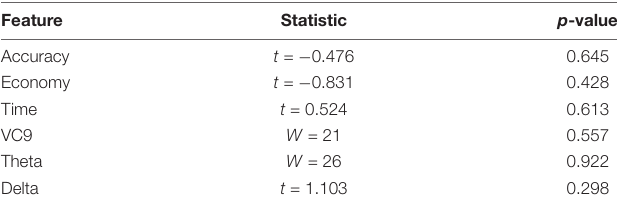
TABLE 2 | t / W statistics and p -values for t -tests/Wilcoxon tests comparing Experiment 1 last trial and Experiment 2 first trial, for participants who participated in both Experiment 1 and Experiment 2 ( n =